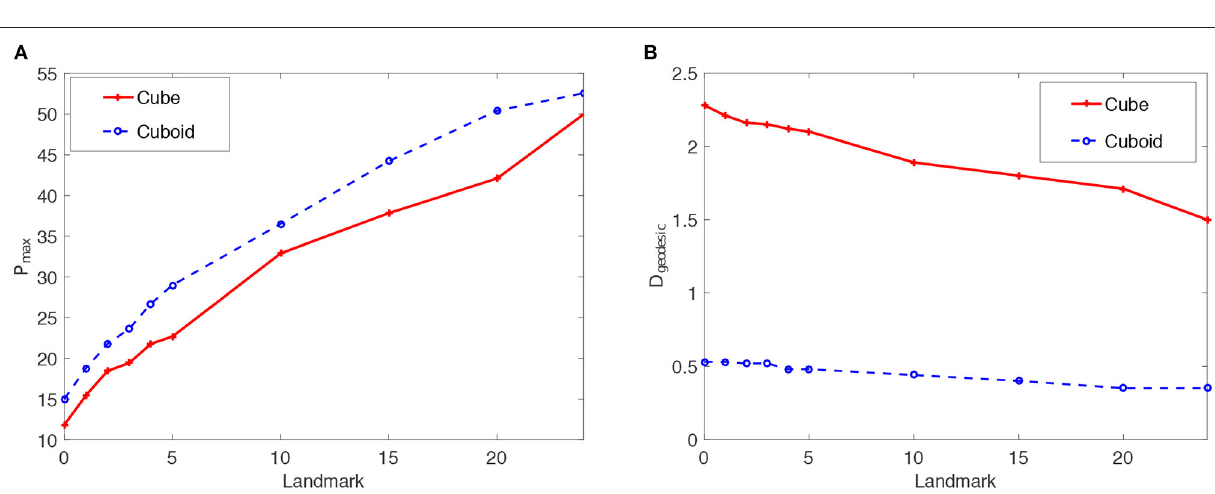
2 2 cube and 3 2 1 cuboid. (A) P max for the models when representing such two 3D objects. (B) D geodesic for the × × × ×